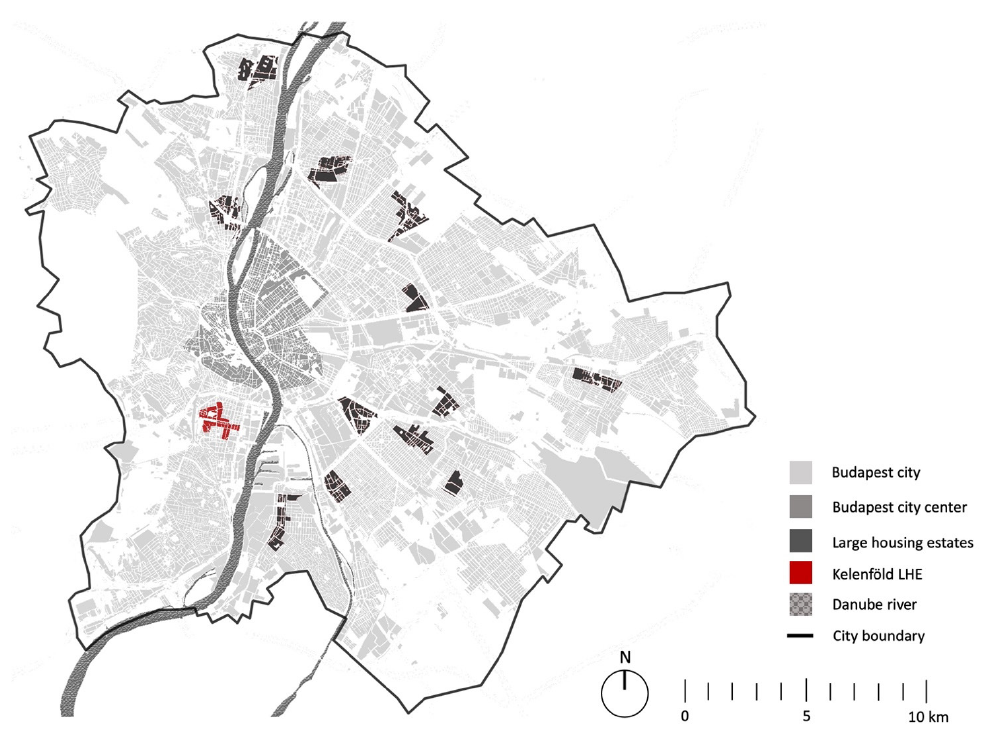
Figure 1. Kelenföld and 12 other LHEs on Budapest map (source: author)